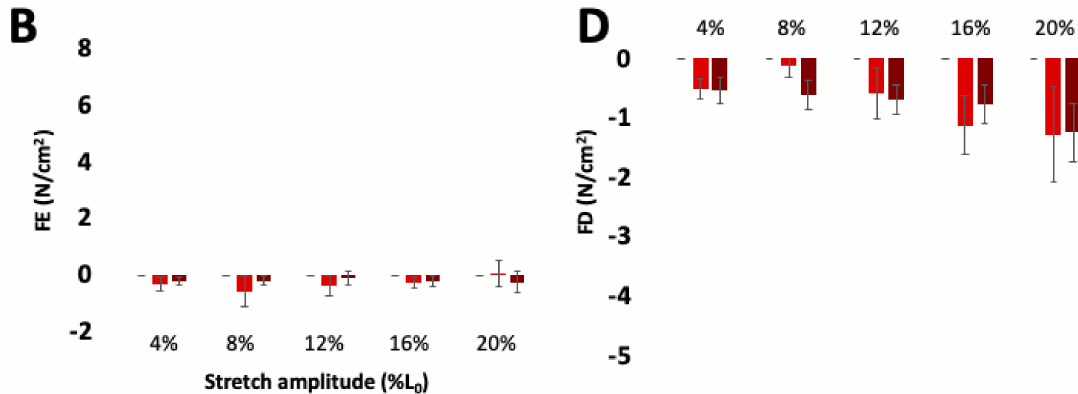
Figure 5. Residual force enhancement ( A , B ) and depression ( C , D ) increase with activation in wild type (blue) but not mdm ( red ) soleus muscles. The contribution of passive stress was subtracted from residual force enhancement and depression. Darker bars indicate maximal activation and lighter bars indicate submaximal activation. Reproduced with permission from Tahir et al. [80]. Copyright 2019, The Company of Biologists Ltd.